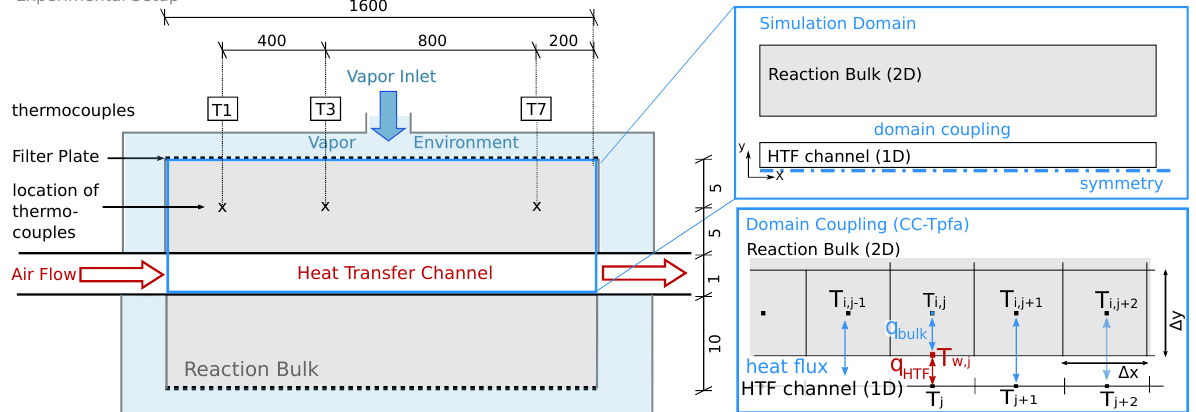
Figure 1. Reactor setup; Left : Experimental setup described in Reference [32]. The solid bulk is kept between filter plates. Water is provided at constant pressure in the surrounding casing. Air flows through the heat transfer channel (HTF) to provide/remove heat. Thermocouples are placed at different locations, here T1, T3 and T7. For better visibility, the figure is not true to scale. The dimensions are given in mm. Top right : In the model, the setup consists of two separate domains, the reactive bulk and the (HTF). The two domains are coupled by a conductive heat flux. Due to symmetry, only half of the bulk domain is simulated. Bottom right : Domain coupling; a heat flux is calculated between the cell centers of the two-dimensional reaction bulk and the 1D HTF